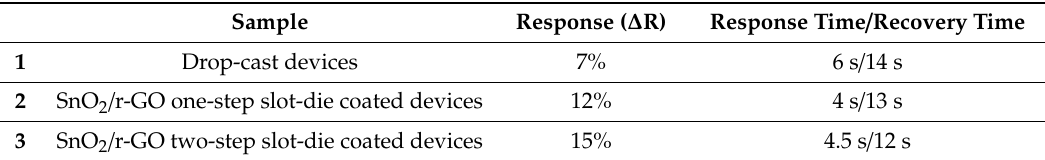
Table 2. Sensing performances of the drop-cast devices, SnO 2 / r-GO one-step slot-die-coated devices, and SnO 2 / r-GO two-step slot-die-coated